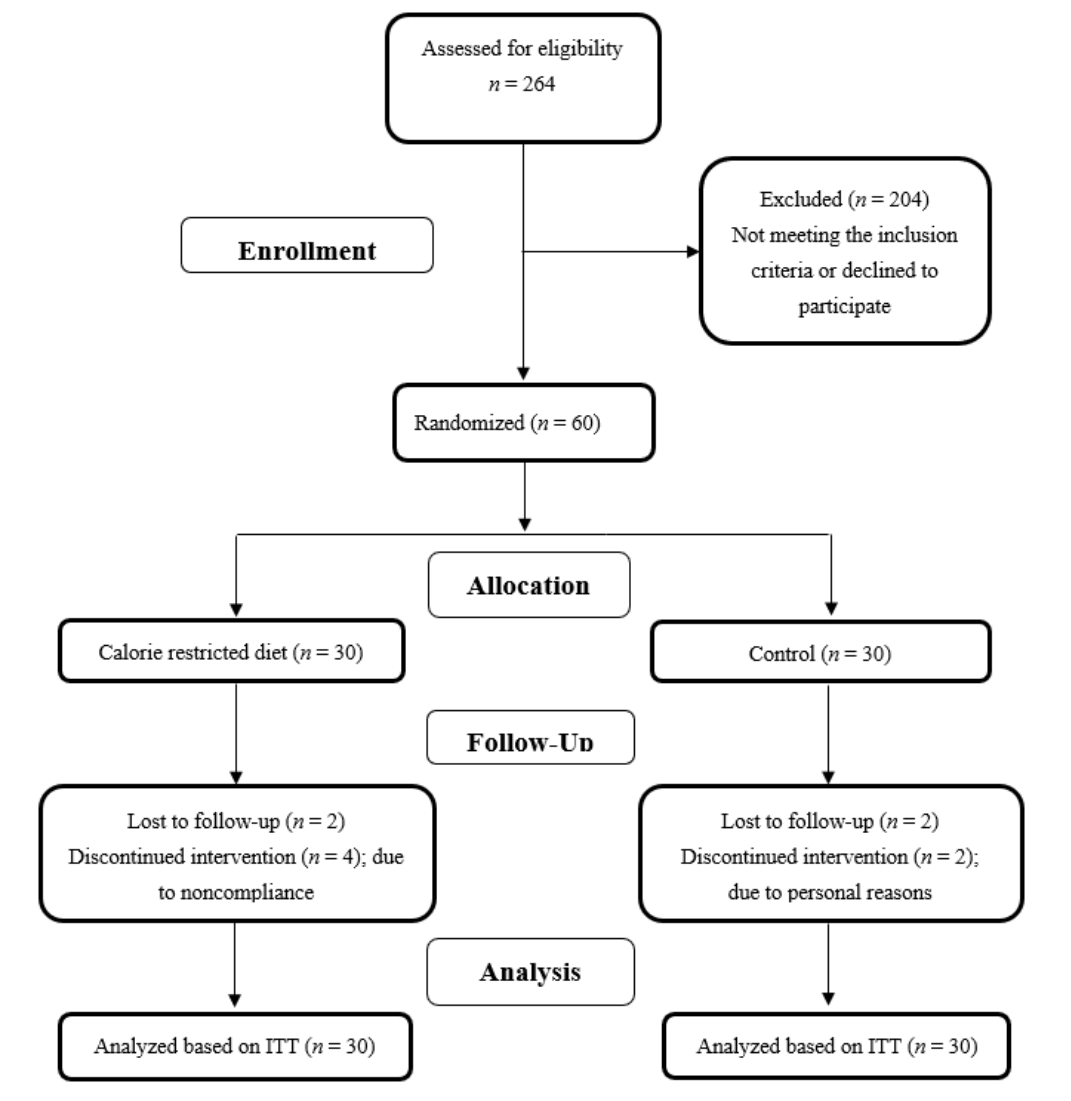
Figure 1. Study flow diagram. Table 1. Baseline characteristics of the study patients.